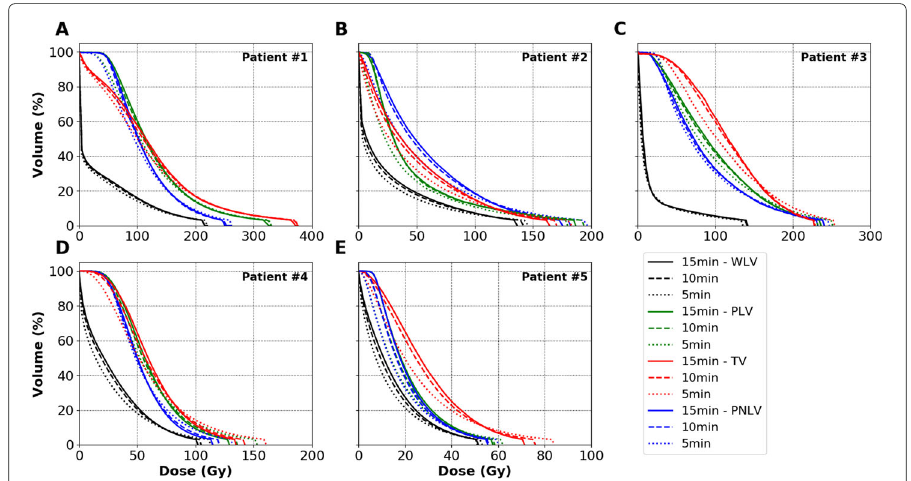
Fig. 7 Effect of acquisition duration on DVH VSV pet for 5 patients. Reconstructions were performed using i3s10-2mm. Volume-axes in all figures have the same corresponding